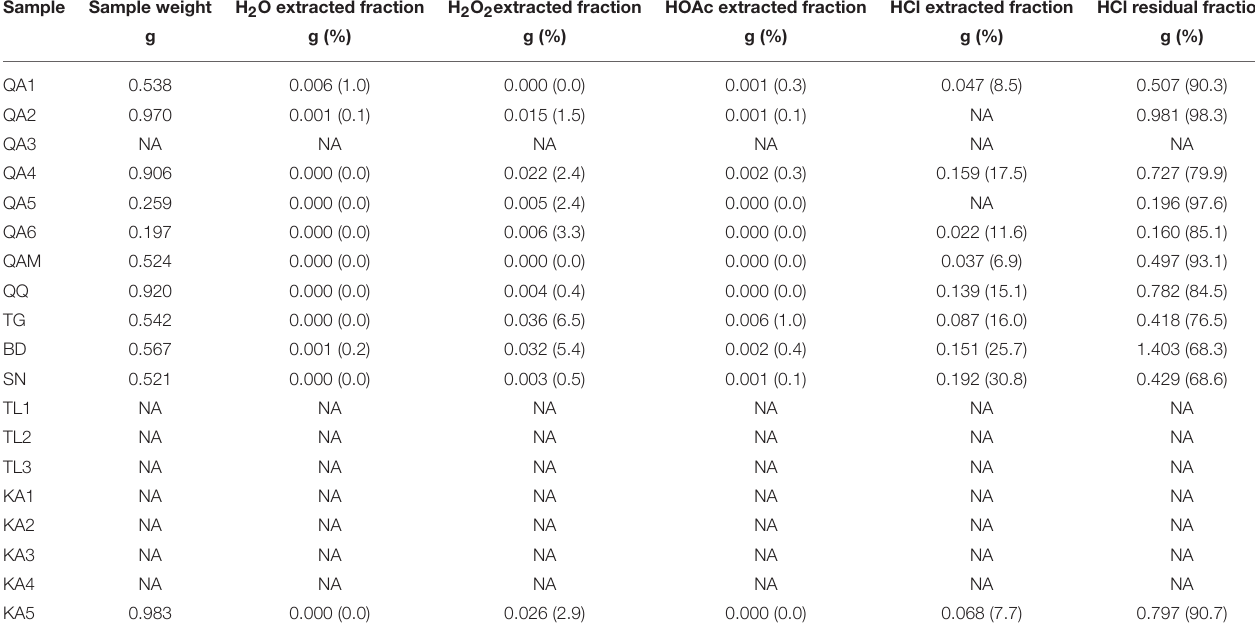
TABLE 2 | Sample weight (dry weight), amounts of extracted fraction and weight percent of extracted fraction to analyzed weight of cryoconite and